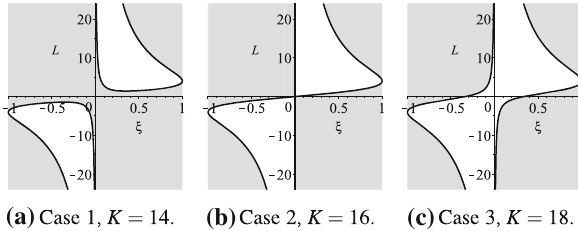
Fig. 1 Allowed ξ motion in dependence of L for J = 4 and varying K . Physically forbidden areas are marked in gray